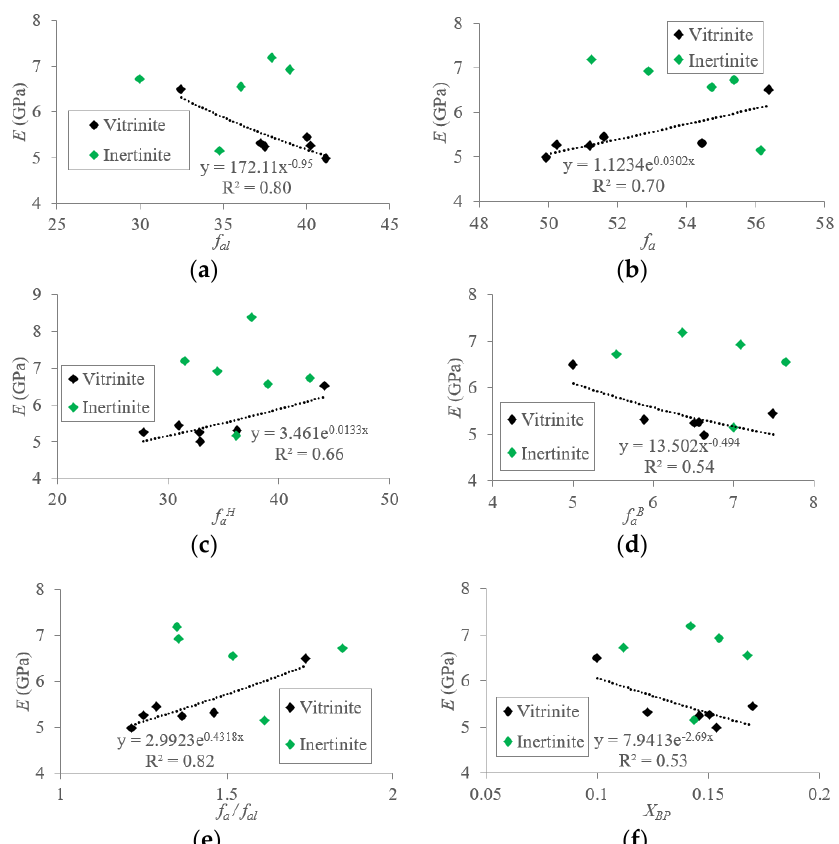
Figure15. RelationshipbetweenNMRparameters(( a – f )arethe f al , f a , f aH , f aB , f a / f al , and X BP , respectively) Figure 15. Relationship between NMR parameters (( a – f ) are the f al , f a , f aH , f aB , f a /f al , and X BP , respectively) and E. (Note: Here, E is the mean value for each and E. (Note: Here, E is the mean value for each sample).